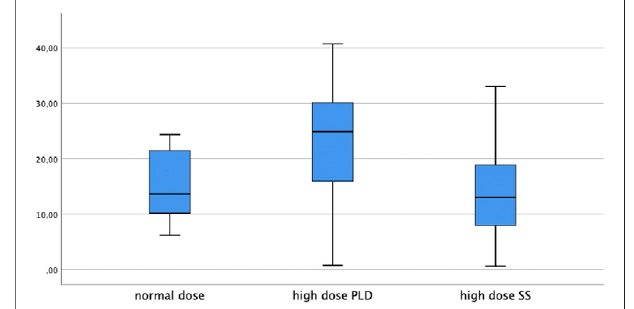
FIGURE 1 | LPV plasma trough levels in μ